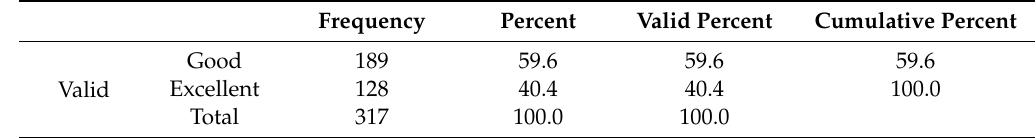
Table A6. Level of